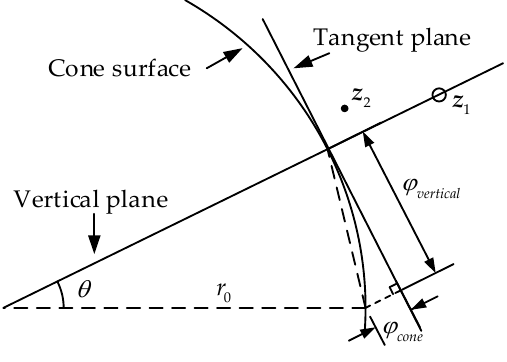
Figure 6. The weight distance diagram of the constraints.